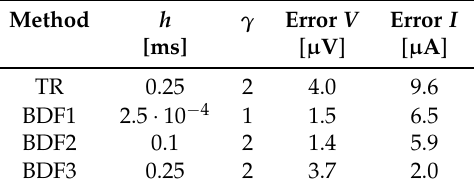
Table 11. Scalable RLC circuit ( N = 2 loops): High-precision configuration of the DAE integration methods.